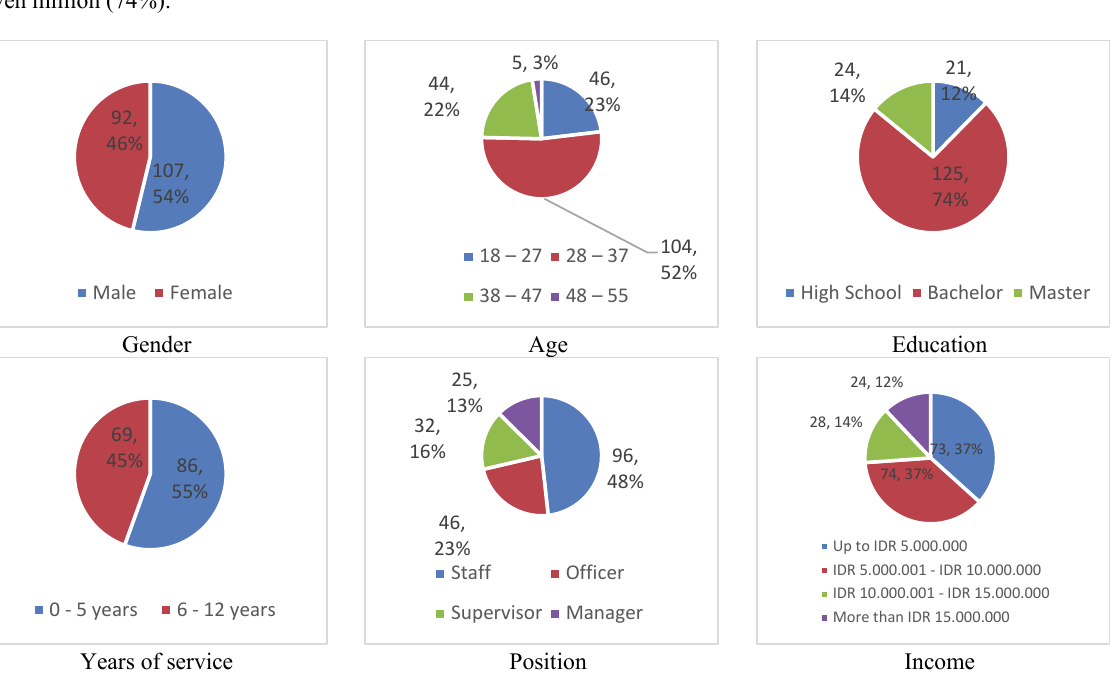
Fig. 1. Profile of